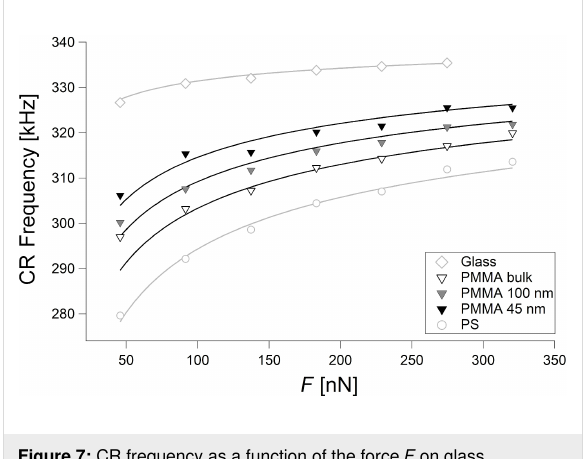
Figure 7: CR frequency as a function of the force F on glass (diamonds), bulk PMMA (white triangles), and bulk PS (circles), as in Figure 6. CR frequencies on two PMMA films, 45 nm and 100 nm thick are shown, too (grey and black triangles, respectively). All curves are fitted with Equation 16 (light grey and black